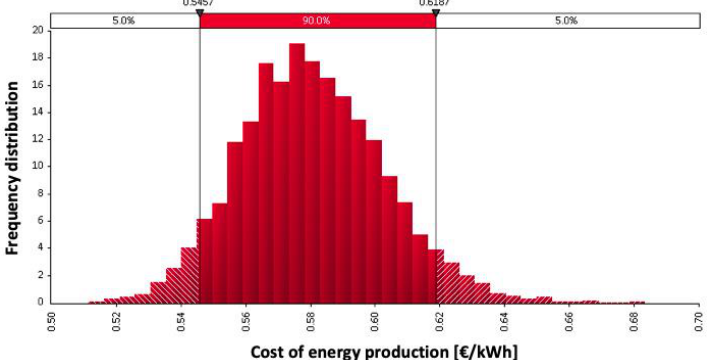
Figure 9. Calculation of the unit cost of energy production based on the forecasted energy values.